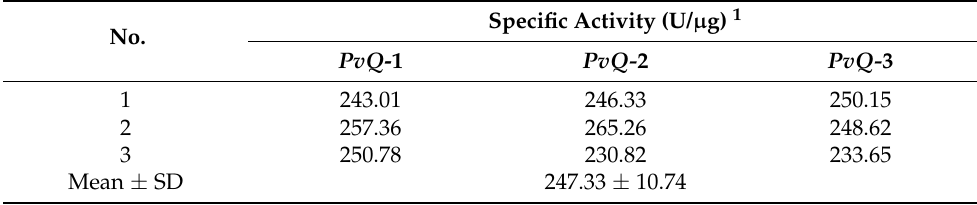
Figure 2. The fibrin-plate assay of PvQ and lumbrokinase. Table 1. The specific activity of PvQ (Mean ± SD, n = 3).